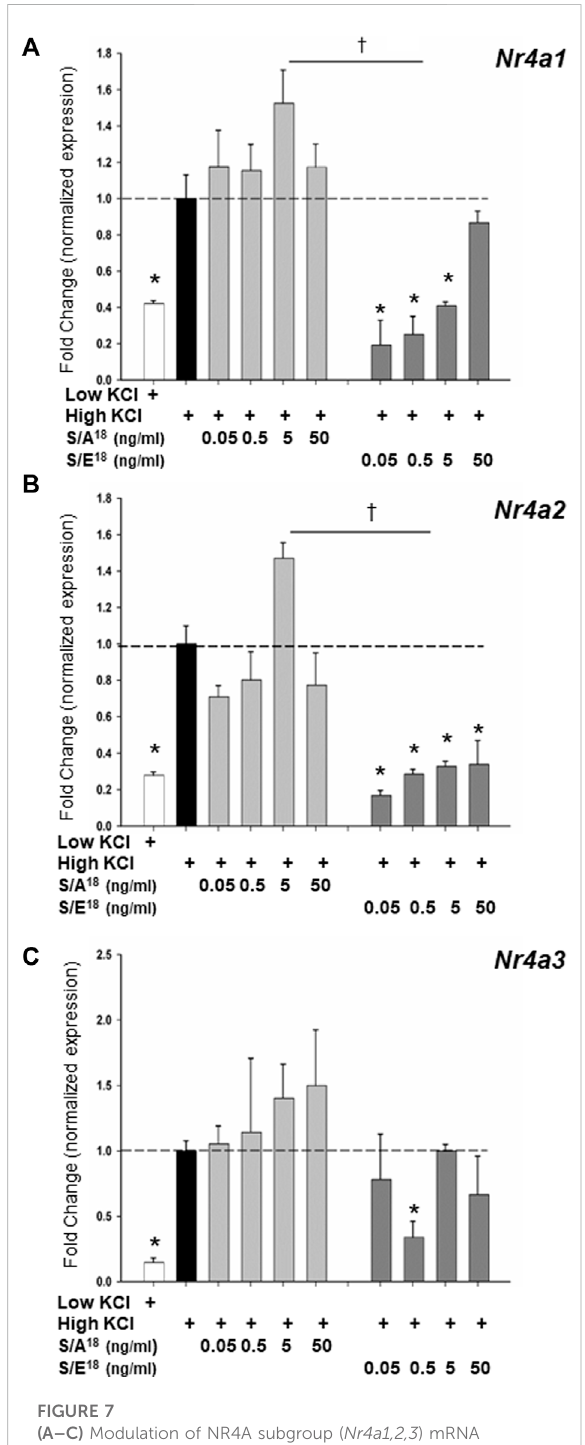
FIGURE 7 (A – C) Modulation of NR4A subgroup ( Nr4a1,2,3 ) mRNA expression in HL-1 cardiac myocytes in response to peptide treatments following membrane depolarization. Membrane depolarization was induced by incubating cell in Krebs- Ringer buffer containing 84 mM KCl and 3 mM CaCl 2 (High